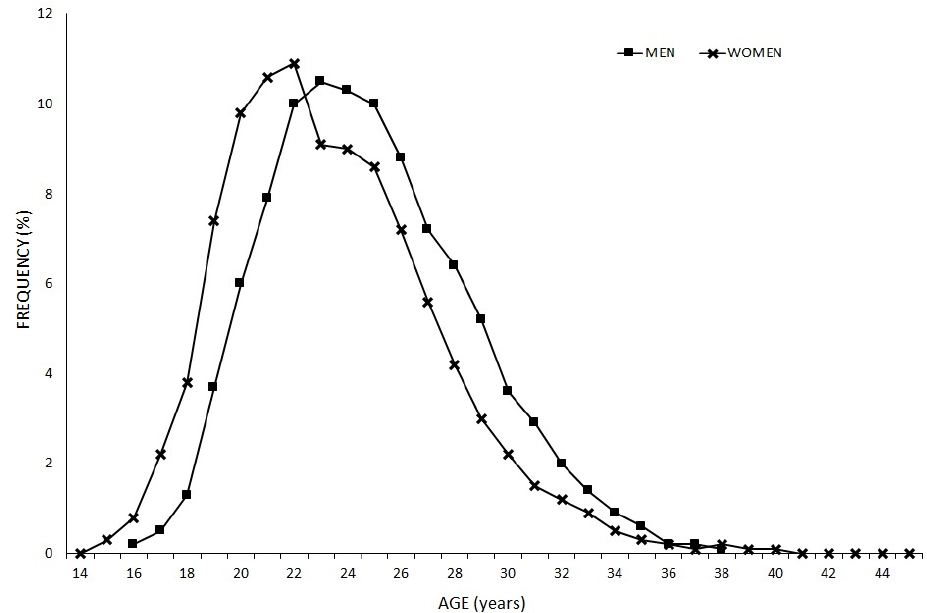
Figure 3. Frequency distribution in relation to age in badminton players (both men and women) with 1-year intervals in the analysed period (1994–2020).